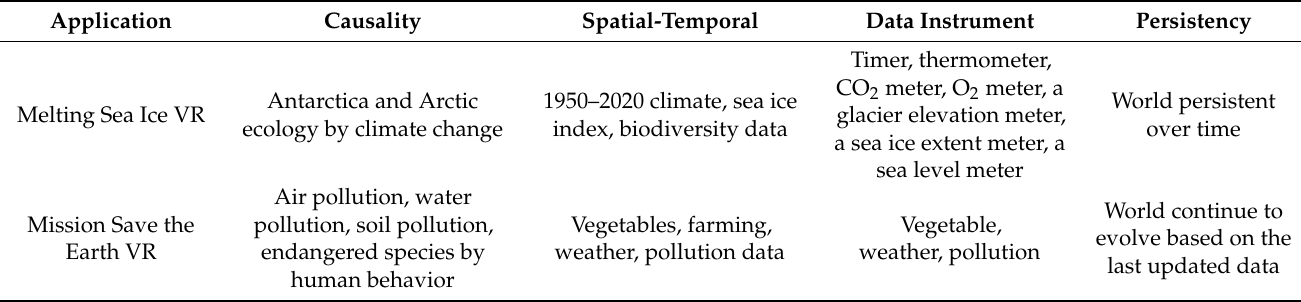
Table 2. Summary of characteristics of the virtual ecosystem model applied to the